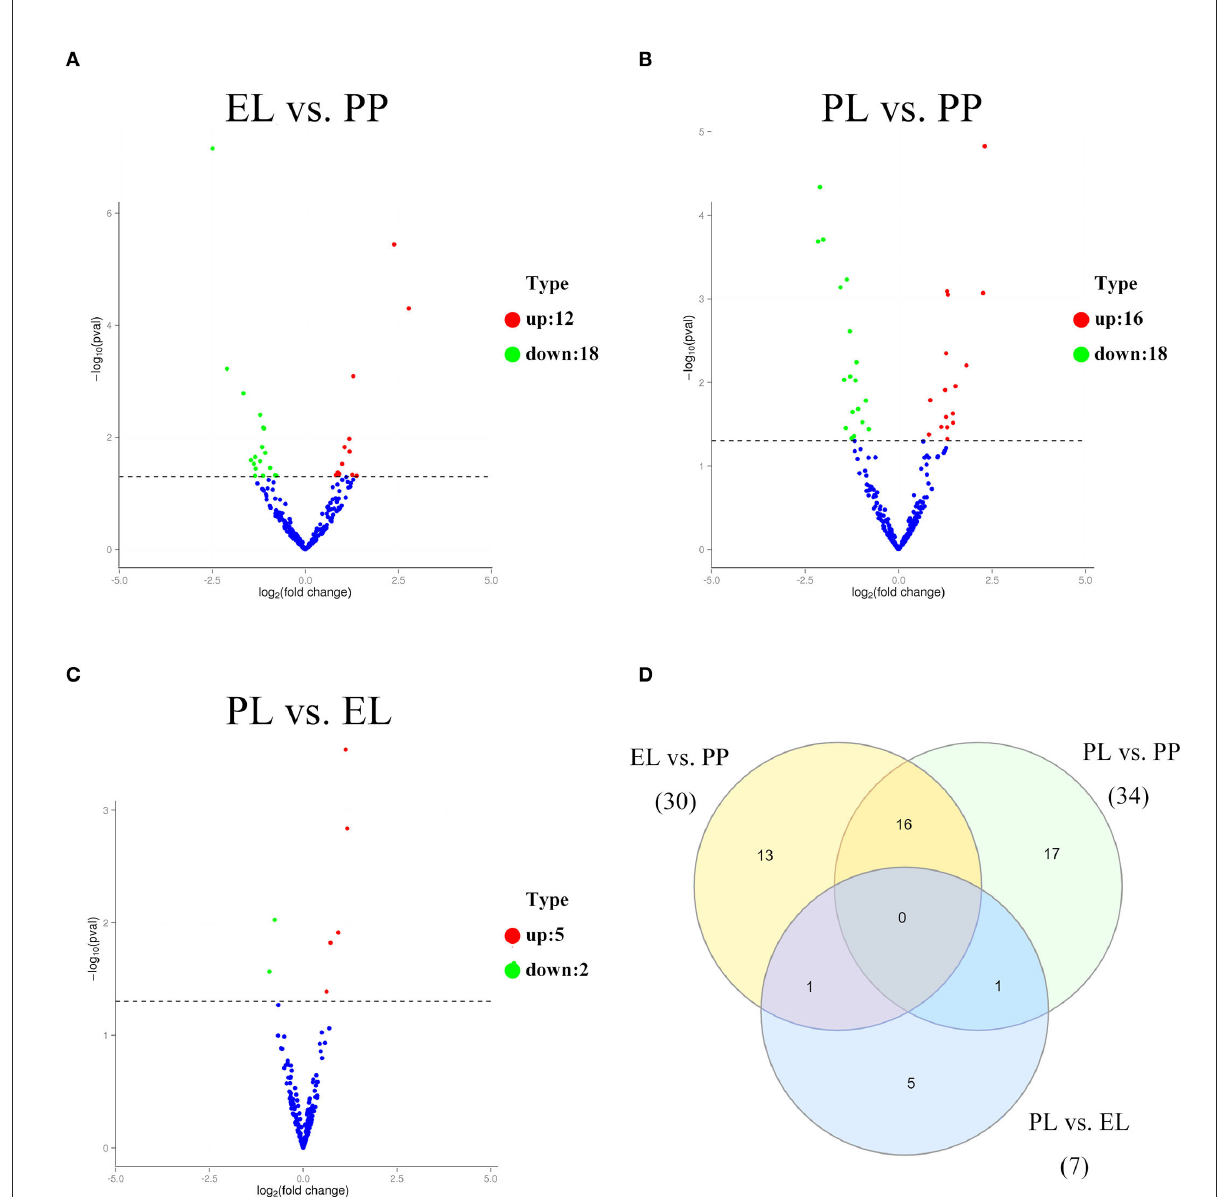
FIGURE2 The volcano plot of differentially expressed (DE) miRNAs identified in early lactation (EL) vs. perinatal period (PP) (A) , peak lactation (PL) vs. PP (B) , and PL vs. EL comparisons (C) . A Venn diagram of DE miRNAs in all three comparisons (D) .